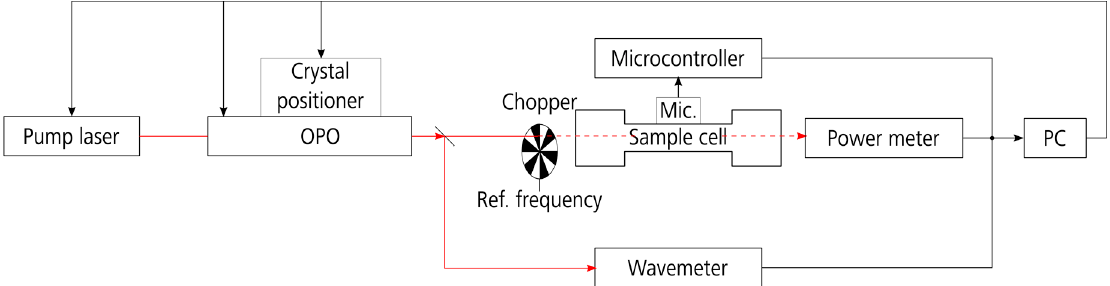
Figure 1. Experimental setup of the photoacoustic sensor.